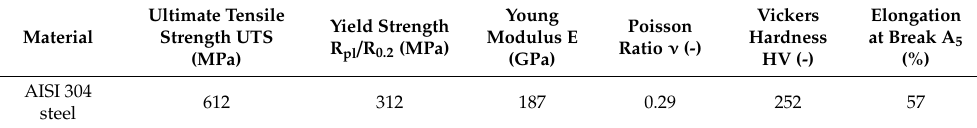
Table 1. Static mechanical properties of the analyzed steel AISI304, based on [24].